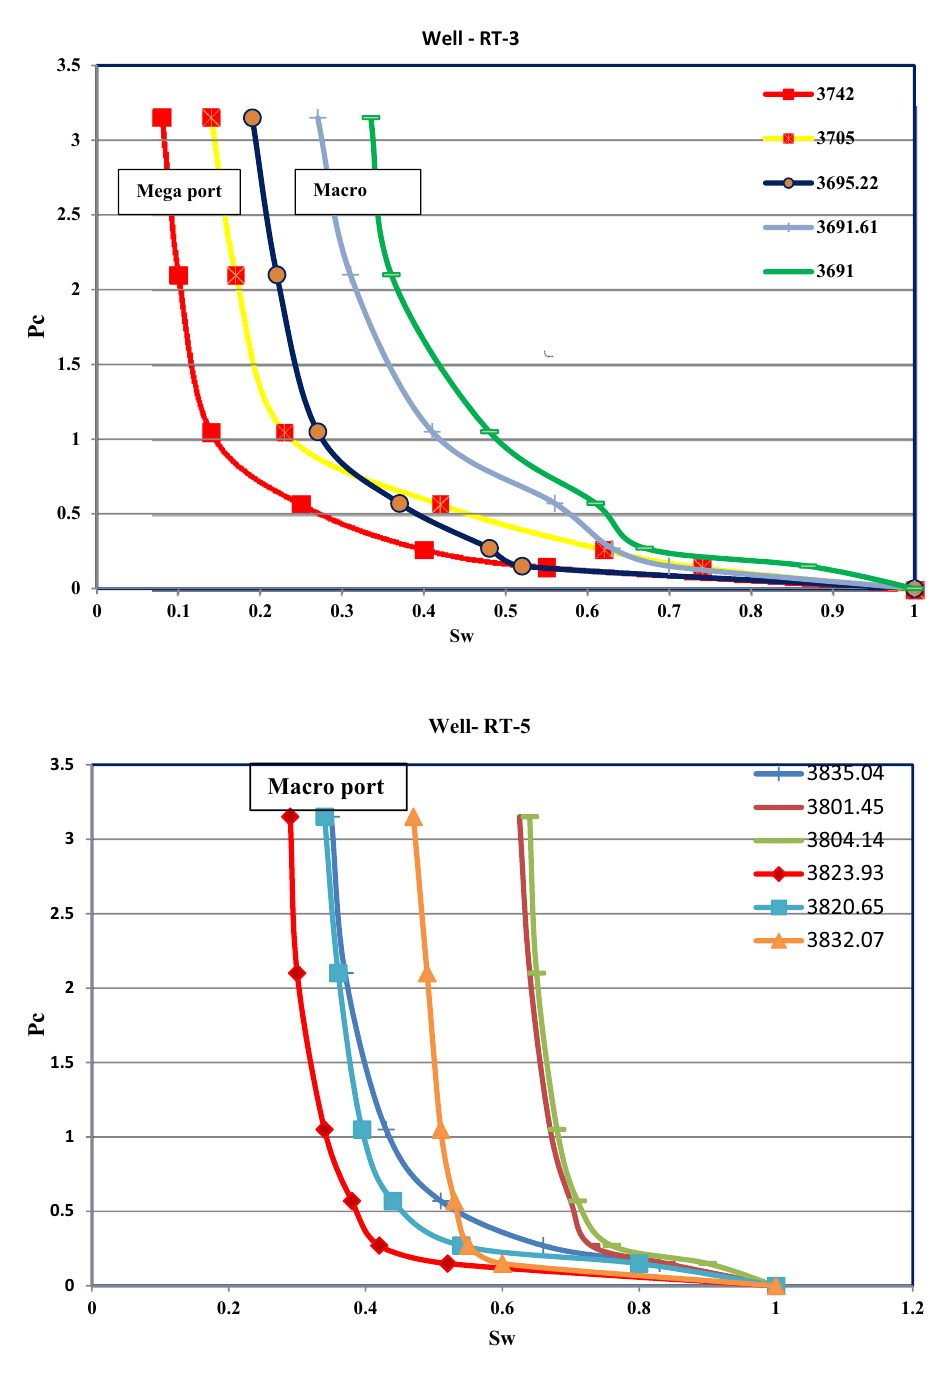
Fig. 12 Capillary pressure analysis for well Rt-3